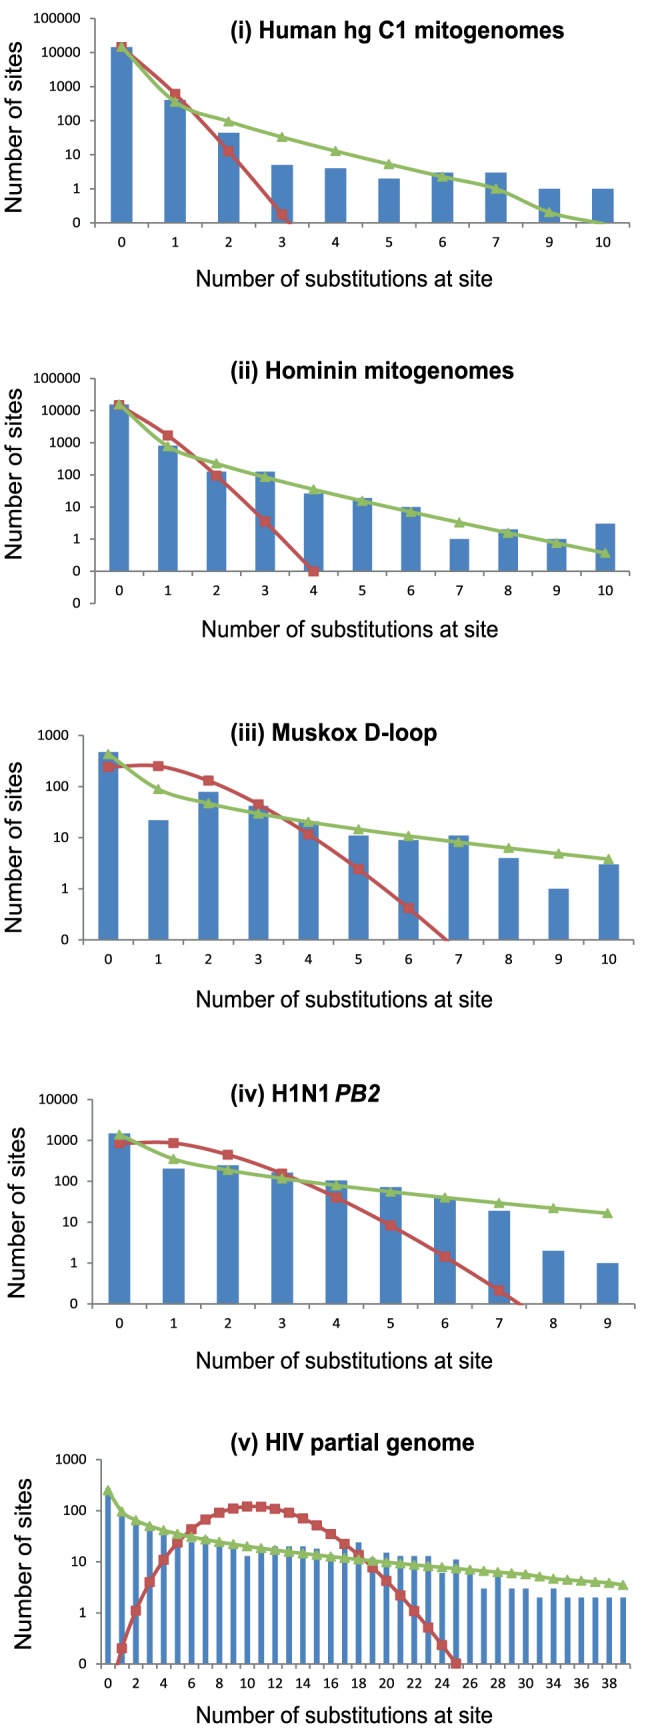
Semi-logarithmic plots of substitutions per site for five intraspecific DNA data sets.Number of substitutions at each site were inferred using parsimony on the Bayesian estimates of the tree topologies. Columns indicate the number of sites against the number of substitutions occurring at each site. Red and green lines indicate the best-fitting Poisson and negative binomial distributions, respectively.